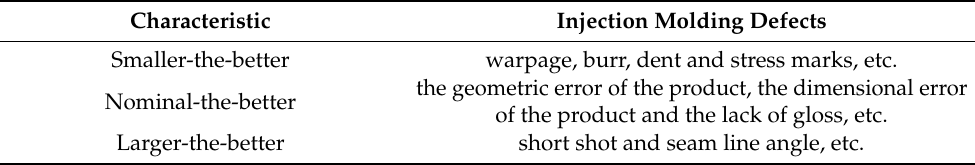
Table 2. Injection molding defects corresponding to different characteristics. Characteristic Injection Molding Defects Smaller-the-better warpage, burr, dent and stress marks, etc. the geometric error of the product, the dimensional error Nominal-the-better of the product and the lack of gloss, etc. Larger-the-better short shot and seam line angle,